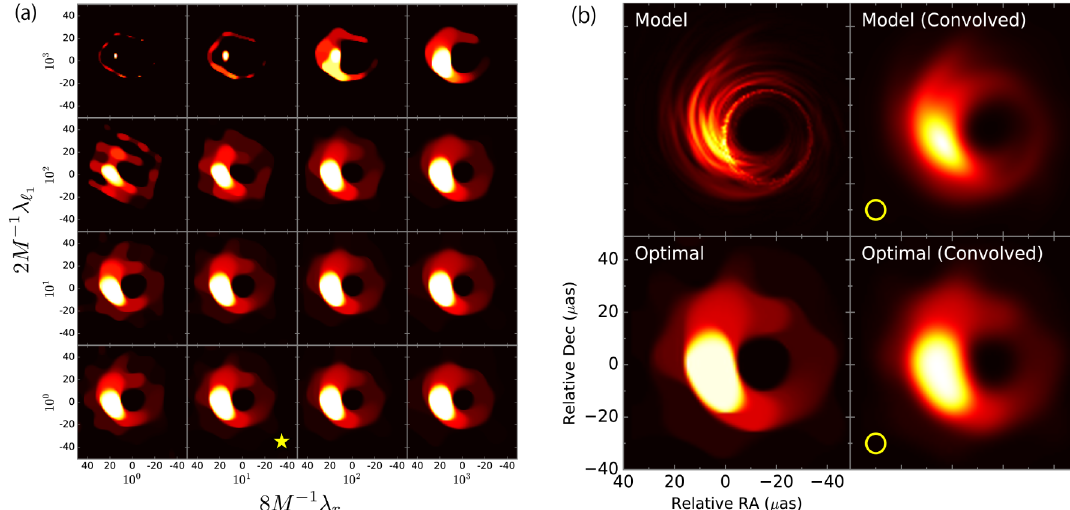
Fig 1. Super-resolution imaging results for Dataset 3 based on model image of supermassiveblack hole at center of nearby elliptical galaxy, M87. (a) Images for all investigatedparameters; the star-marked panel is obtainedat the optimum parameters. (b) Originalimages (top) and reconstructed images (bottom) at optimalparameters ((2 λ ℓ images are convolved with a circularGaussian beam on the right-handside, the full width at half maximum (FWHM) of which is 25% of the nominalangularresolutionof the EHT and corresponds to the diametersof the yellow circles. This coincides with the optimal resolution minimizingthe mean squareerror